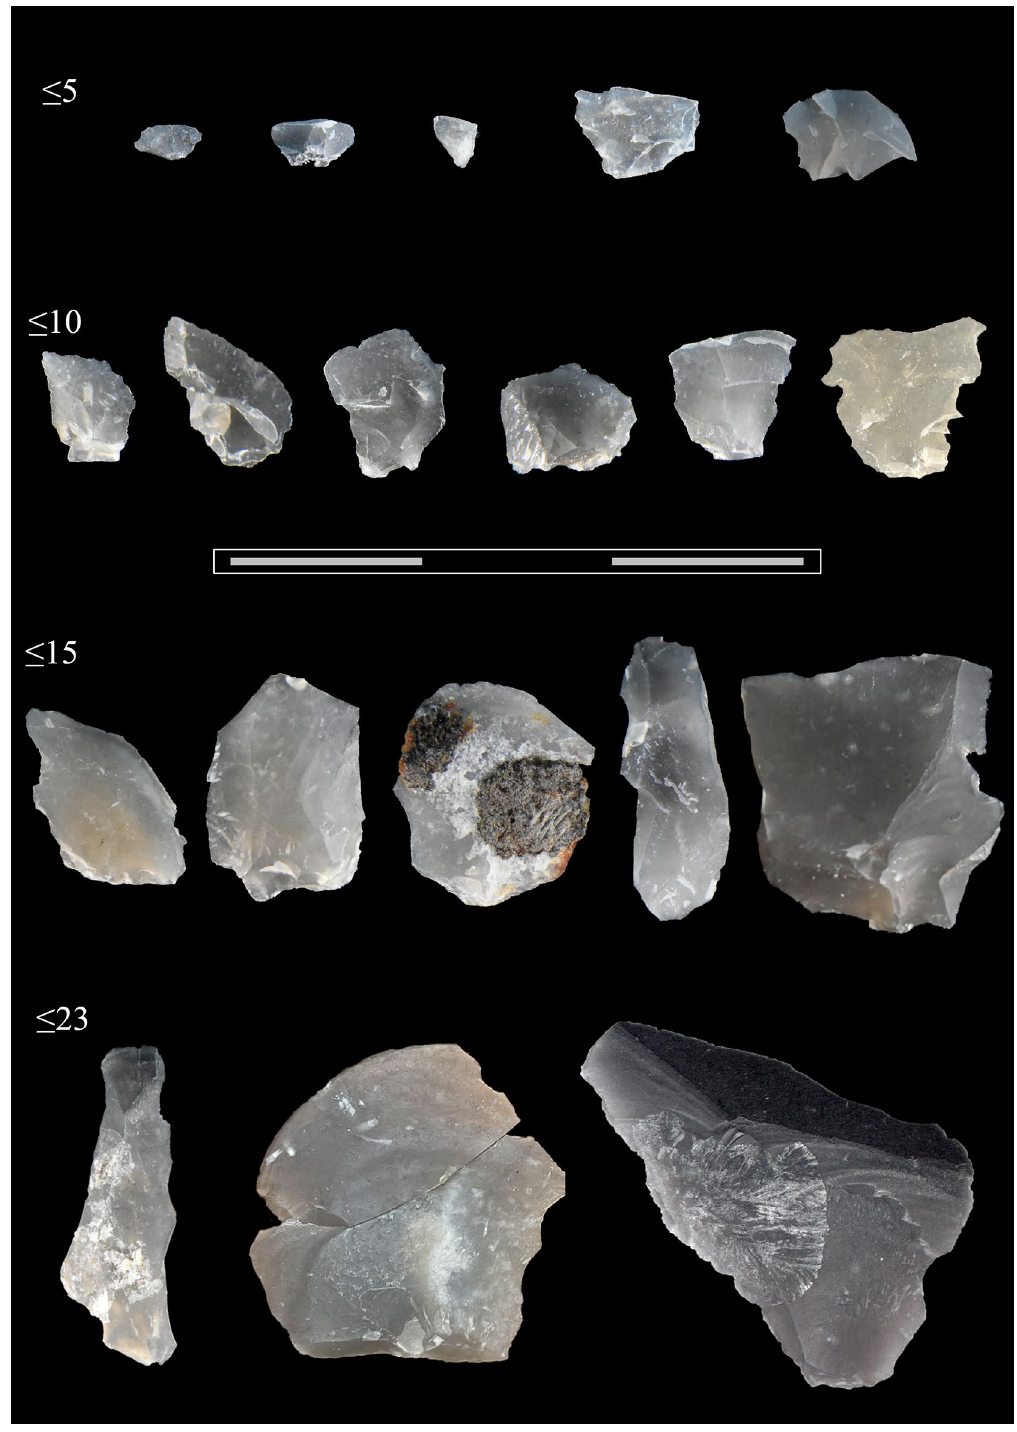
Figure 1. Overview of the resharpening flakes from Schöningen 13 II-3. Complete flakes are grouped attending to the technological dimension and according to the following ranges identified in the assemblage: ≤ 5